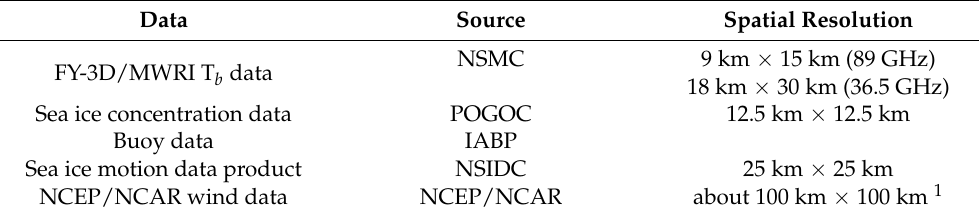
Table 1. Basic information of the data used in this study. Data